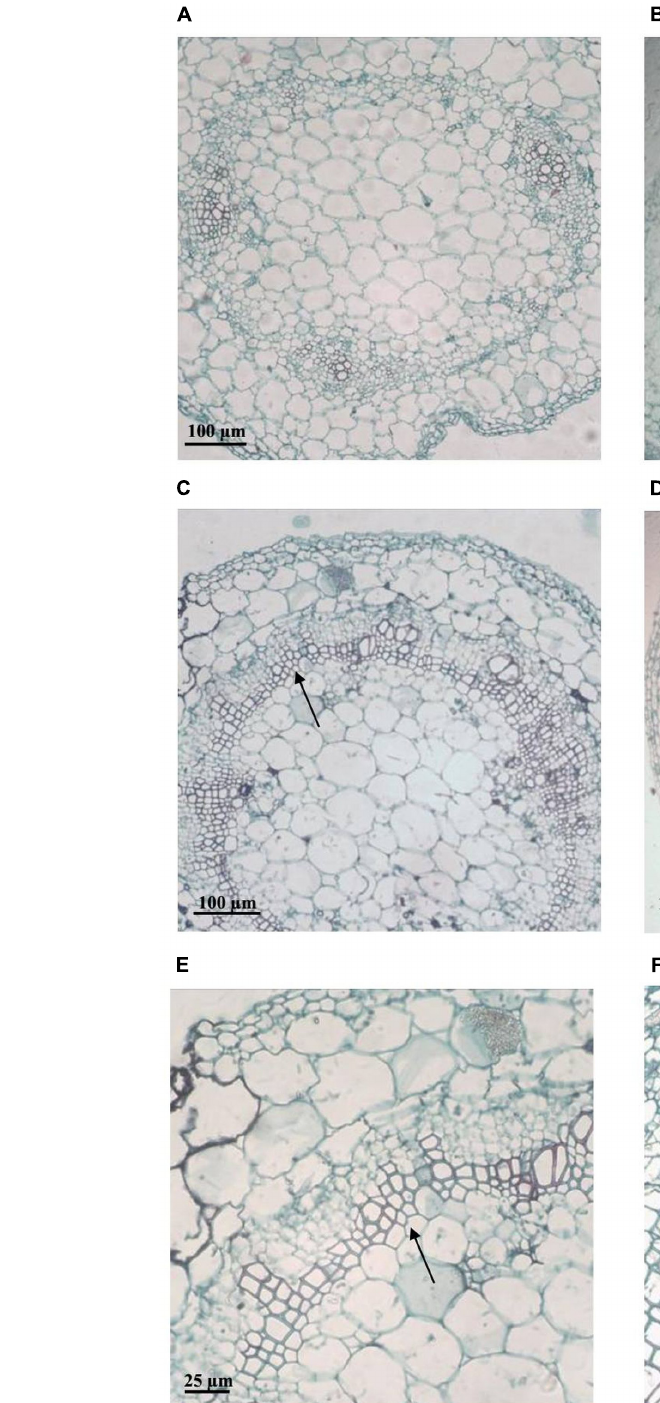
Frontiers in Plant Science |